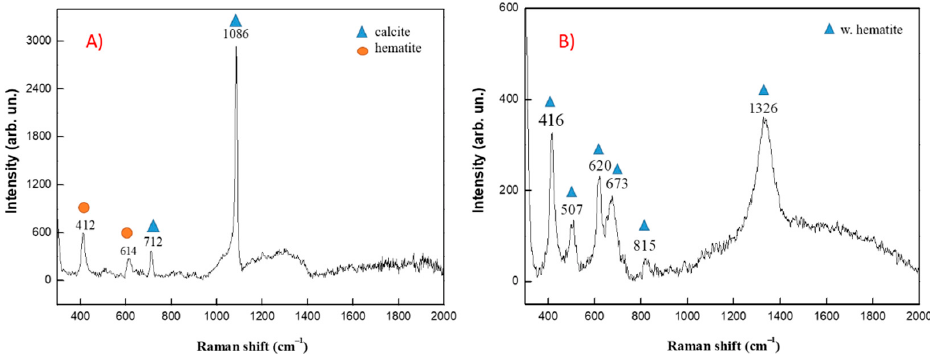
Figure 22. Raman spectra of red pigment; ( A ) in situ, point 1; ( B ) sample.